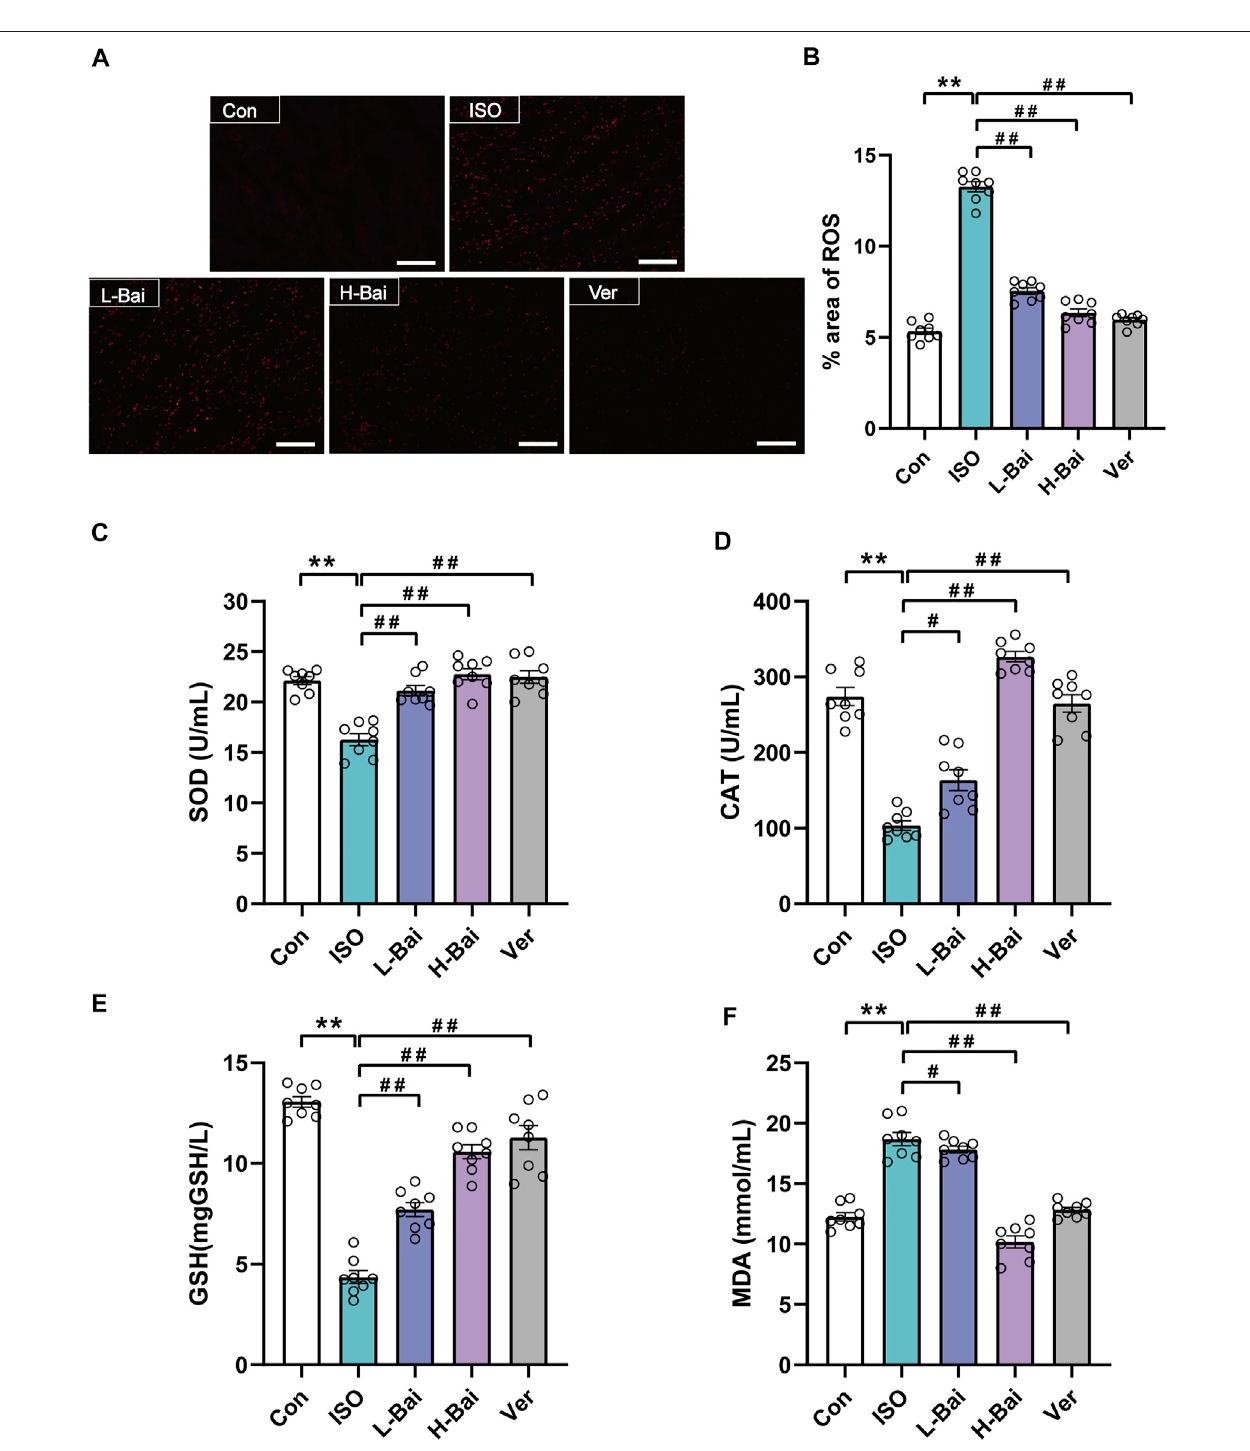
FIGURE 4 | Effects of Bai on oxidative stress. (A) The fl uorescence intensity images for reactive oxygen species (ROS) were observed by fl uorescent probe dihydroethidium (DHE) at a magni fi cation: ×200 in each group. Scale bar = 100 μ m. (B) The area percentages of ROS levels were calculated. (C-F) Effects of Bai on activities of superoxide dismutase, catalase, and glutathione (SOD, CAT, GSH, respectively) and concentration of malondialdehyde (MDA). Values are denoted by means ± S.E.M. p < 0.01 versus Con; p < 0.01, p < 0.05 versus ISO.